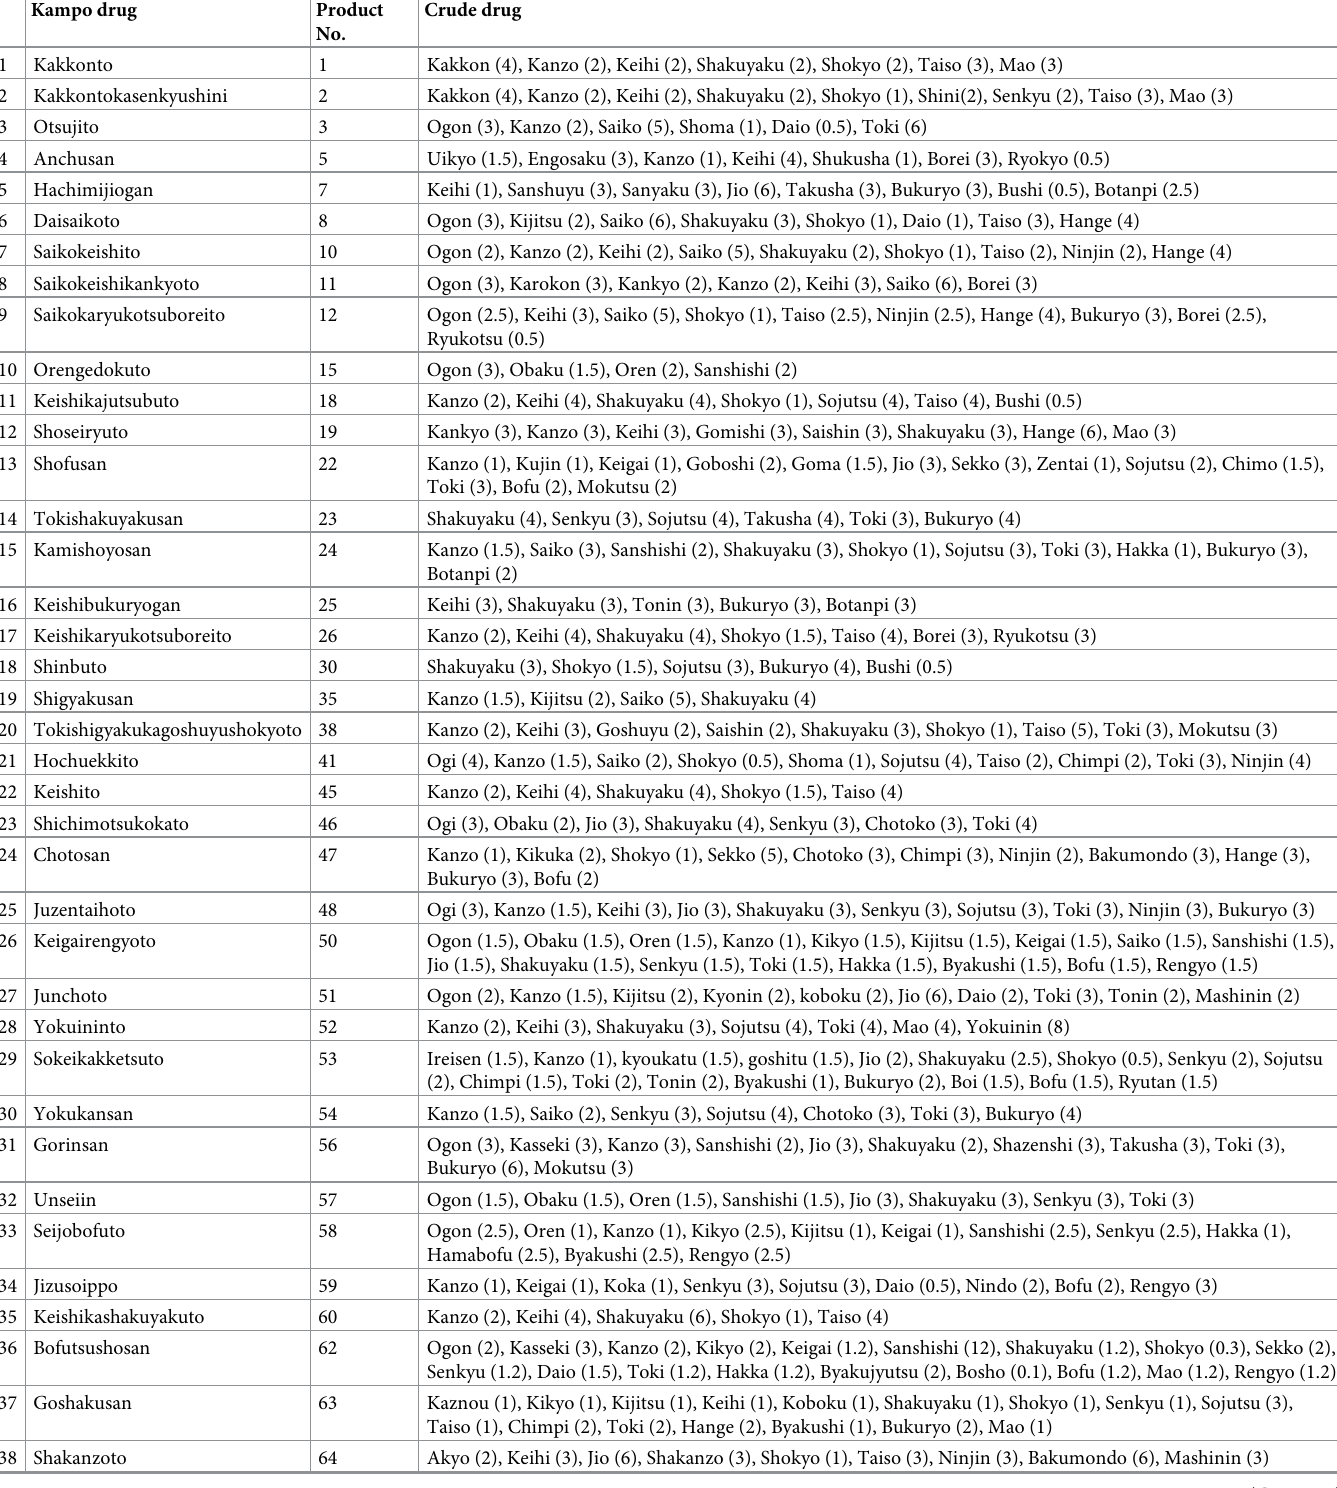
Table 1. Library of 74 approved Kampo drugs screened for therapeutic effects in preeclampsia, and the quantity of crude drugs (g) per daily dose. Kampo drug Product